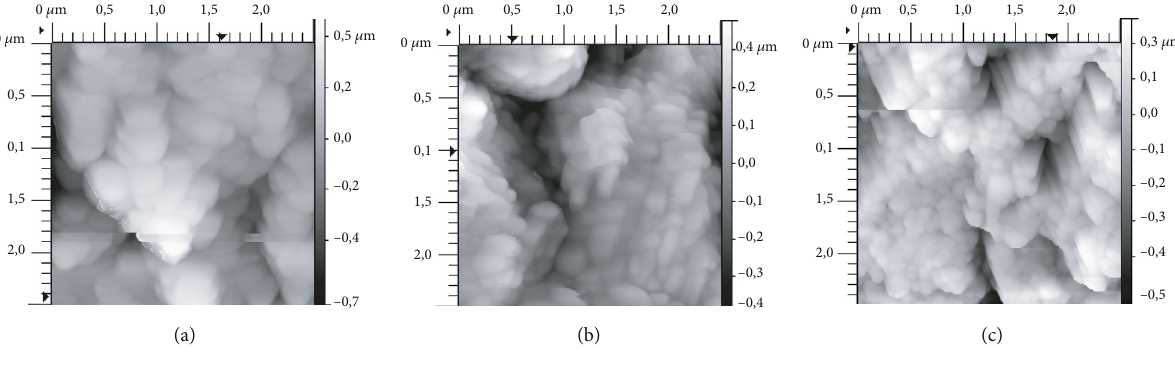
Figure 6: AFM images for (a) ZnO, (b) ZnO:Ag 1%, and (c) ZnO:Ag 5% thin fi lms. and TiO /sensitizer thin 2 2 18.4